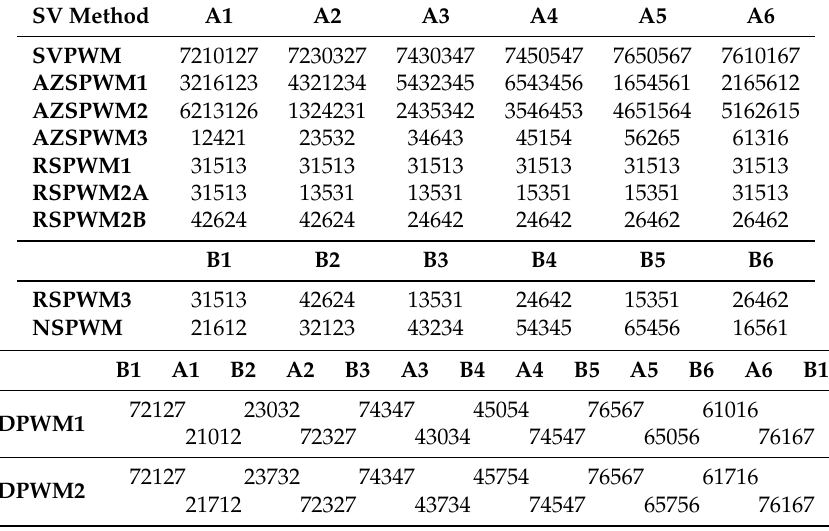
Figure 4. Reference voltage formation for the RCMV-PWM. Shaded areas indicate the regions where the depicted sets of vectors are employed. Table 1. Vector patterns for various space-vector